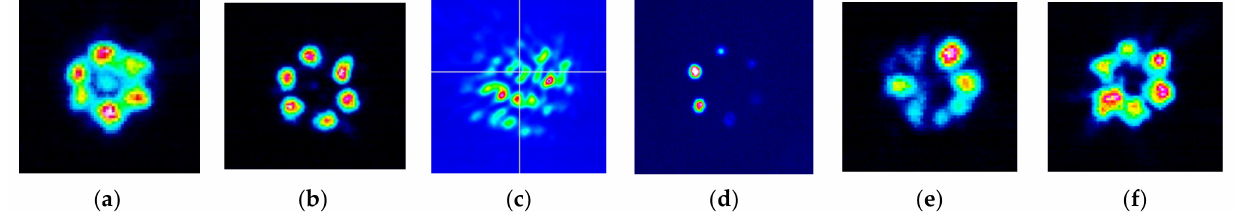
Figure 15. Far-field laser beam profiles ( λ = 1550 nm), measured at the receiving end after propagation over 5 m long twisted graded-index six-core-MOFs: ( a ) 50 rpm, SL, free space; ( b ) 100 rpm, SL, free space; ( c ) 100 rpm, DFB laser, MMF 50/125; ( d ) 100 rpm, BLD, MMF 100/125; ( e ) 50 rpm, SL, SMF free space; ( f ) 100 rpm, SL, SMF free